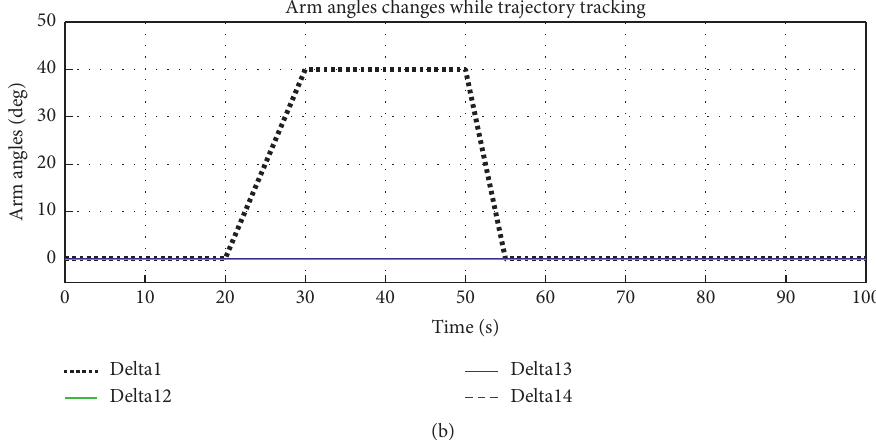
Figure 10: Change curve of arm length and angle.